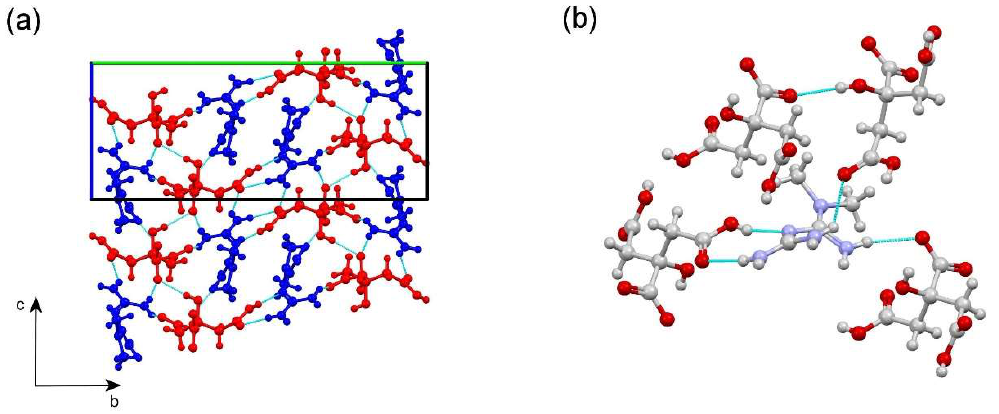
Figure 4. ( a ) View of the 3D structure of MTF–CIT (red: CIT - , blue: MTF + ). ( b ) View of the MTF + cation surrounded by four CIT - anions in MTF–CIT crystal structure.